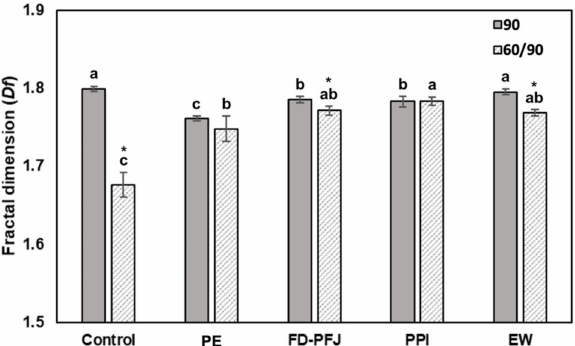
Figure 4. Fractal dimension ( Df ) of binary images of Pacific whiting surimi gels with different inhibitors heated to 90 ◦ C directly (90) and held at 60 ◦ C for 30 min prior to heating to 90 ◦ C (60/90). PE, potato extract; FD-PFJ, freeze-dried potato fruit juice; PPI, potato protein isolate; EW, egg white. Different letters indicate a significant difference ( p < 0.05) among the samples for each heating condition, and the symbol (*) indicates a significant difference ( p < 0.05) between the heating conditions for each